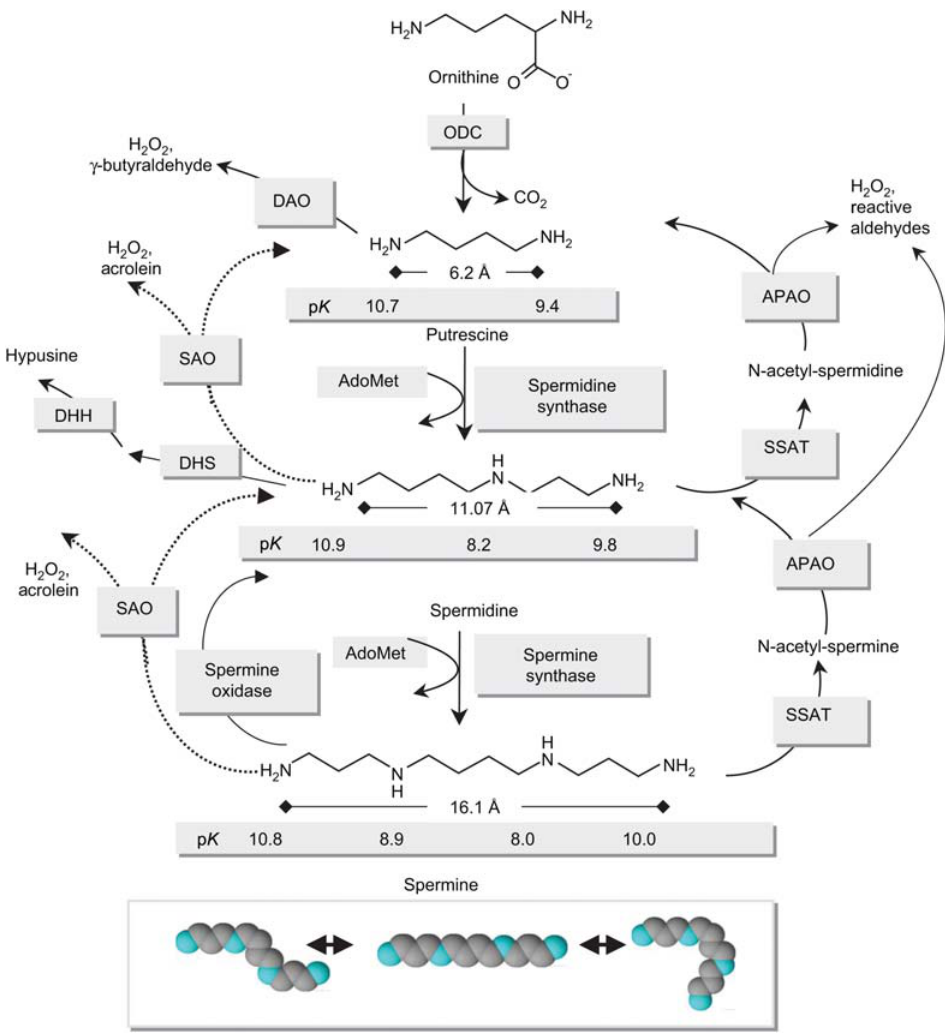
Figure 1 The major mammalian polyamines putrescine, spermidine, and spermine. A simplified scheme of their biosynthesis, interconversion, metabolism, major products, and the involved enzymes (dotted arrow: low activity in humans). ODC, ornithine decarboxylase; spermidine synthase, spermine synthase; SSAT, spermidine/spermine-N 1 -acetyltransfer- ase; APAO, acetylpolyamine oxidase; DAO, diamine oxidase; SAO, serum amine oxidase; DHS, deoxyhypusine synthase; DHH, deoxy- hypusine hydroxylase. p K a values of amino groups are taken from (8). The ACD/3D Viewer software (www.acdlabs.com) was used for determining distances between terminal nitrogens in the linear molecules and illustrating the flexibility of spermine by depicting three of its almost ‘infinite’